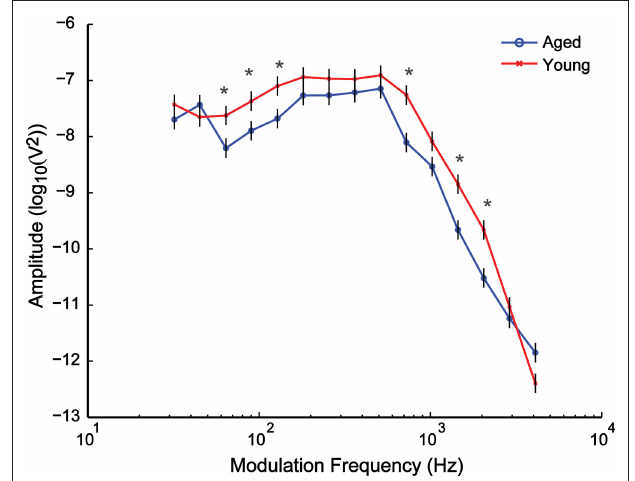
Figure 2 | Similarity in overall shape and nature of the curves was observed when comparing the temporal modulation-transfer function (tMTF) of young and aged animals. The x axis shows the modulation frequencies in a logarithmic scale, and the y axis shows the least squares means (LSM) ± SE of the FFT amplitudes. Asterisks indicate statistically significant difference in LSMs ( P < 0.05, MANOVA).